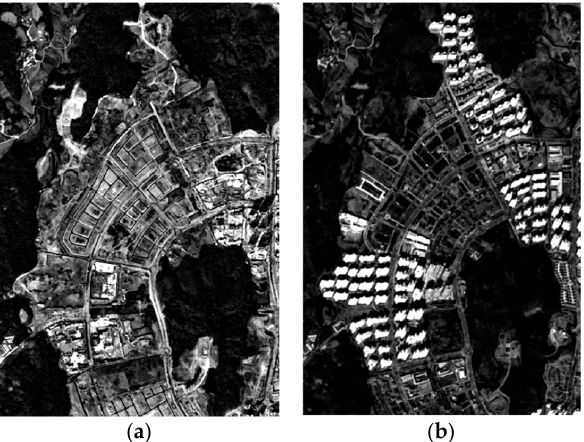
Figure 6. MBI feature images of the second subset: ( a ) MBI T1 and ( b ) MBI T2.